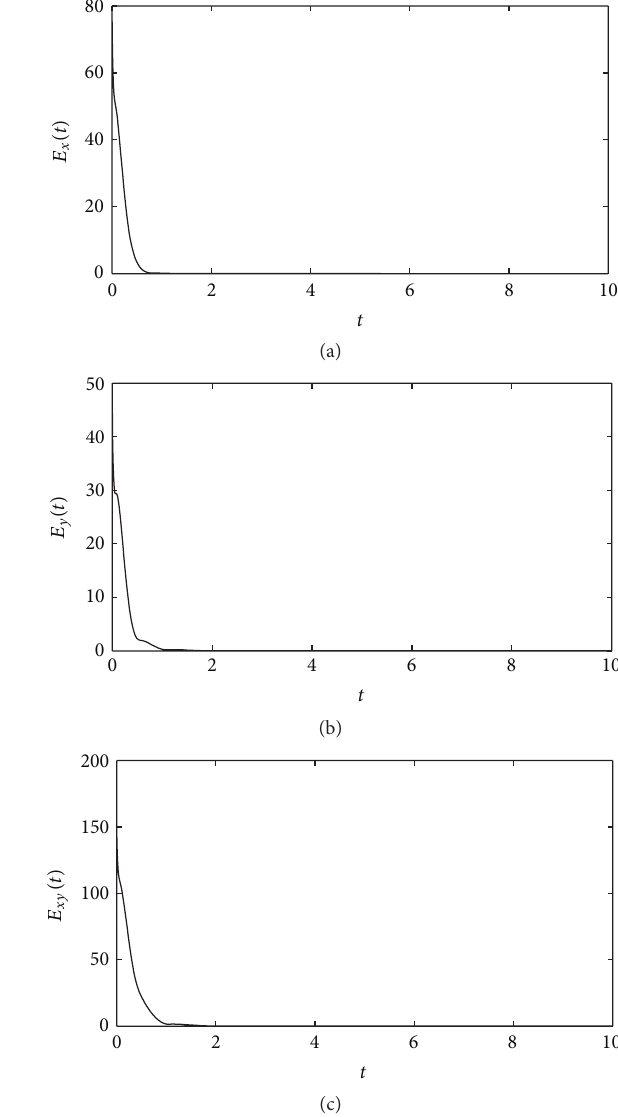
Figure 3: The trajectories evolution of the state variable, (a) 𝑥 𝑖 1 (𝑡) , (𝑡) , (b) 𝑥 𝑖 (𝑡) , 𝑦 𝑖 (𝑡) , and (c) 𝑥 𝑖 (𝑡) , 𝑦 𝑖 (𝑡)(𝑖 = 1, 2, . . . , 5) . 𝑦 𝑖 1 2 2 3 3